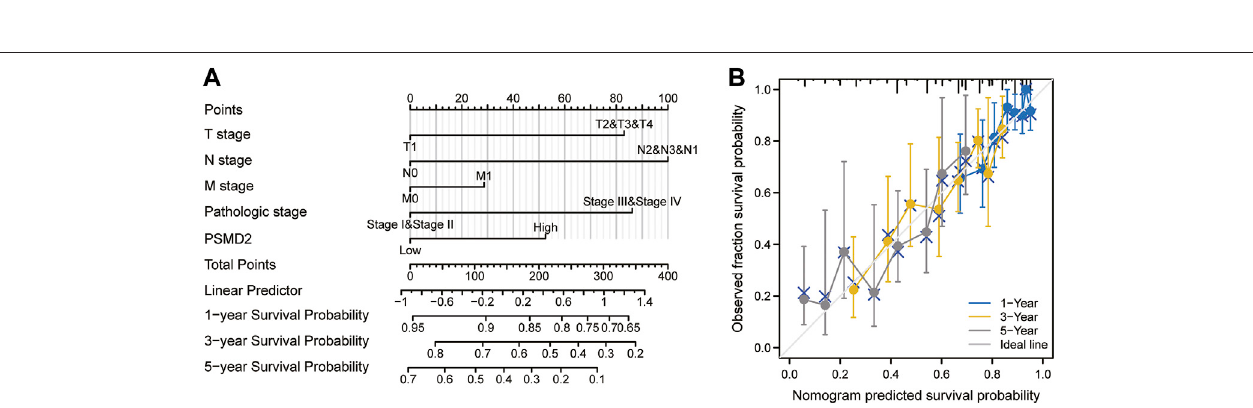
FIGURE 4 | A nomogram and calibration plot for predicting the 1-, 3-, and 5-year overall survival probability of lung adenocarcinoma patients. (A) To predict the survivalprobability, fi rst draw avertical linefrom each clinical factor uptothe points axisand get apoint. Repeat until points forall clinicalfactors are decided. Sum all the points and then locate the total point on the total points axis. Draw a line straight down to the risk axis and fi nally obtain survival probability. (B) Calibration plot of the nomogram.